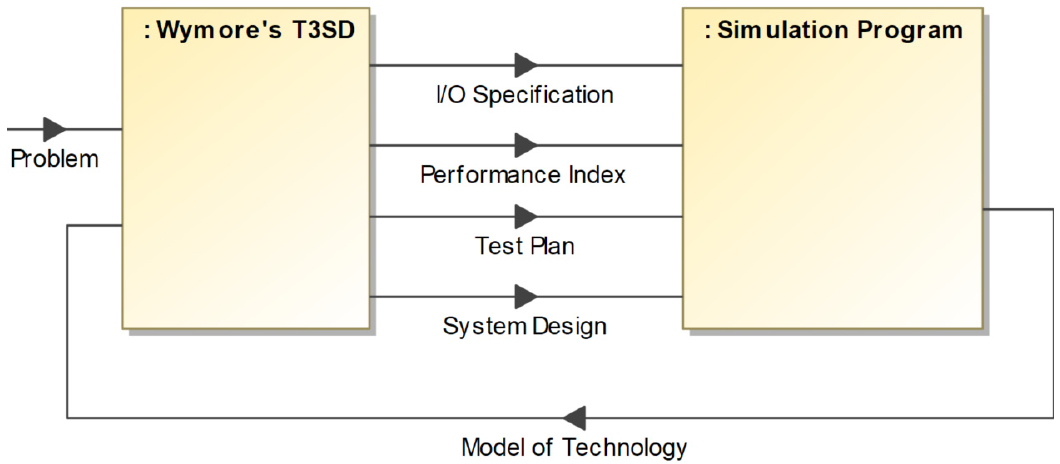
Figure 13. A description of the relationship between T3SD and simulation. The problem is an input to T3SD from stakeholders. The output from T3SD is the specification of required input/output (I/O), the required performance of the systems design (Performance Index), plan for testing the system design (Test Plan), and discrete event representations of the system design (System Design).